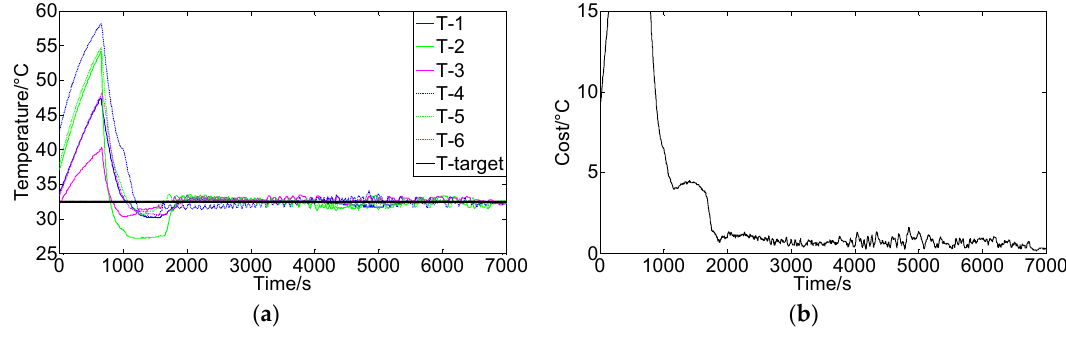
Figure 10. ( a ) Control results of the FCPIDNN controller when fan 2 failed (target temperature is 32.5 °C); ( b ) Variation of the square root of the cost function ( (cid:3493) J( n )).